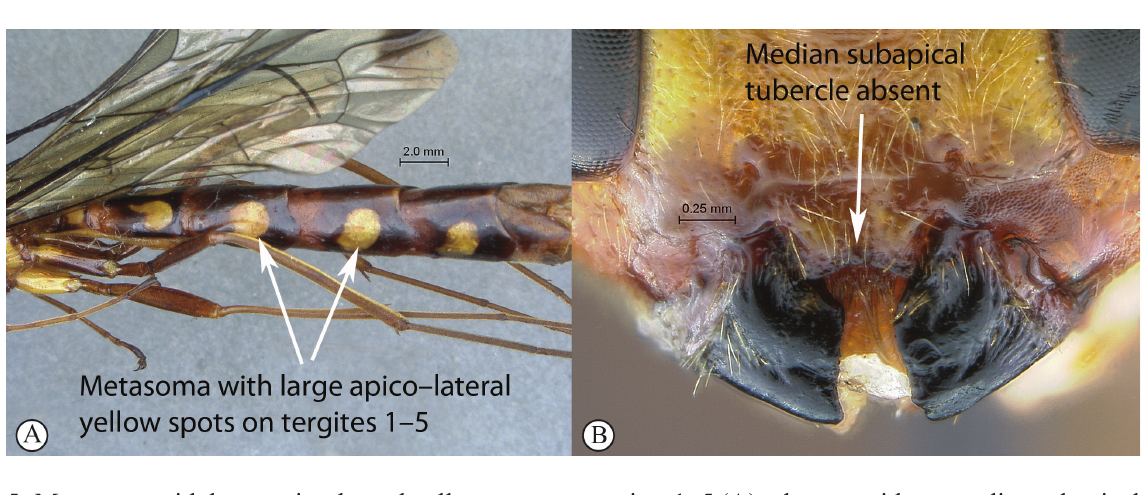
5. Metasoma with large apico-lateral yellow spots on tergites 1–5 (A); clypeus without median subapical tubercle (B); body and ovipositor large to very large (B > 25mm; OT > 6) …… E. overlaeti Seyrig,